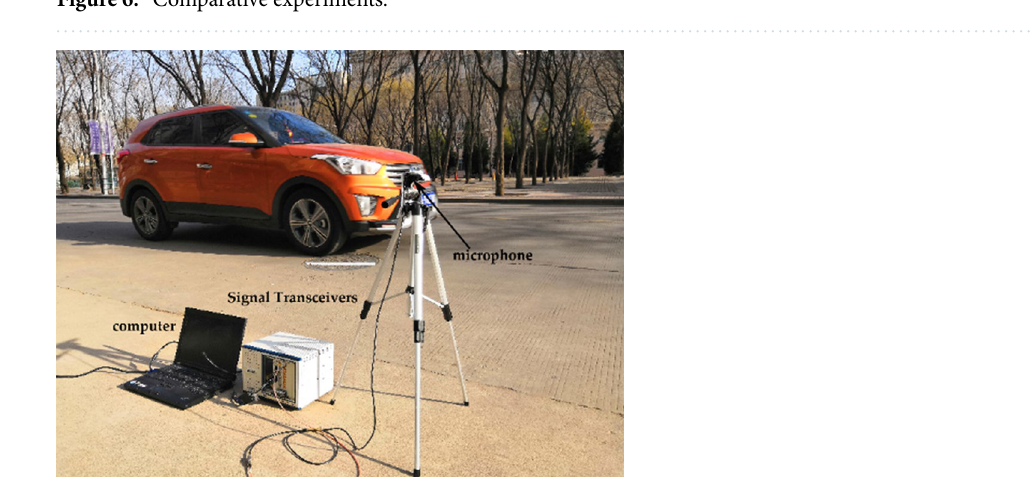
Figure 6. Comparative experiments.